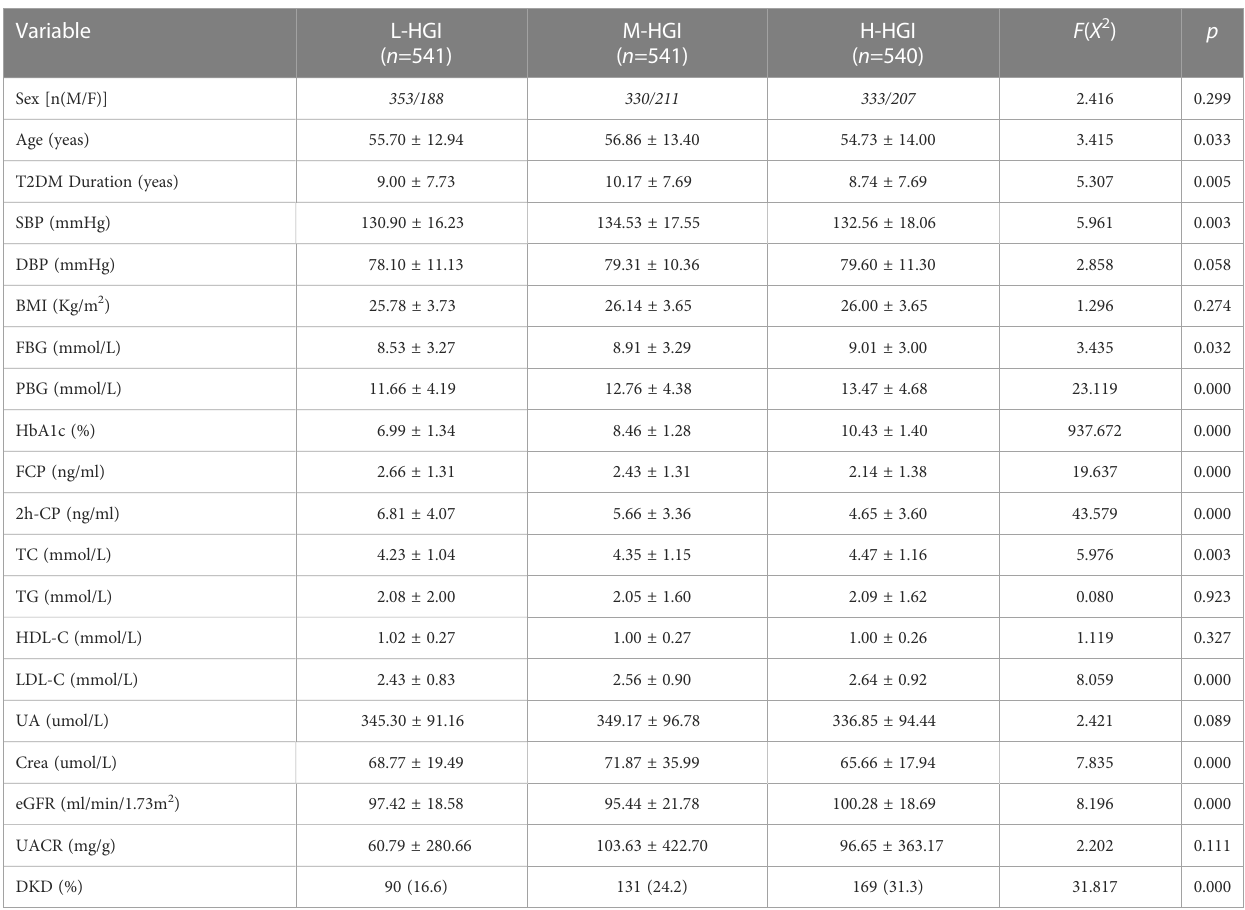
TABLE 1 Comparison of general data and biochemical index results in each group.